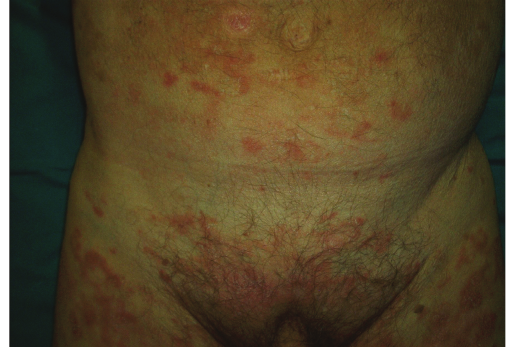
Figure 3: Epidermis showed hypergranulosis and suprabasal clefts containing acantholytic dyskeratotic keratinocytes (H&E